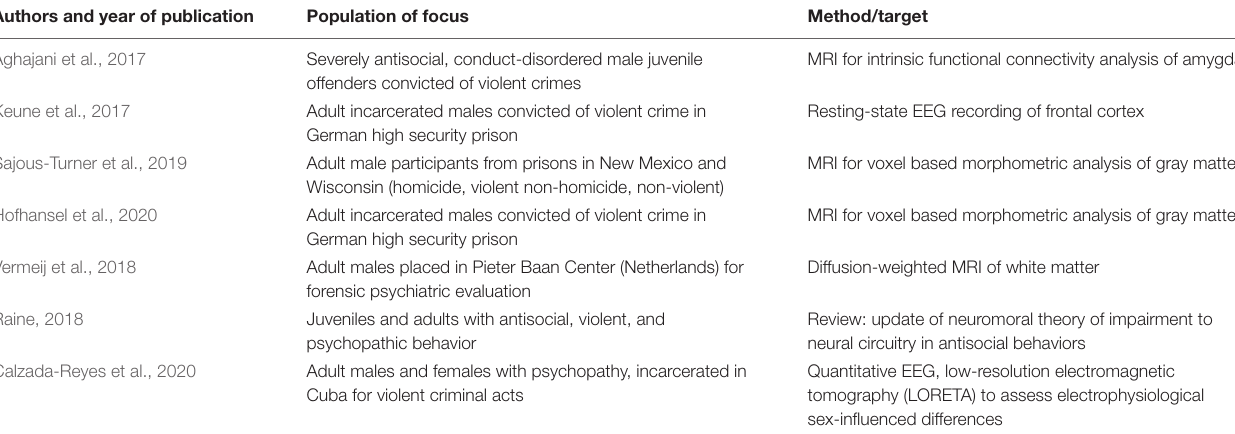
TABLE 1 | Authors, year of publication, subjects, and methods of articles selected for the